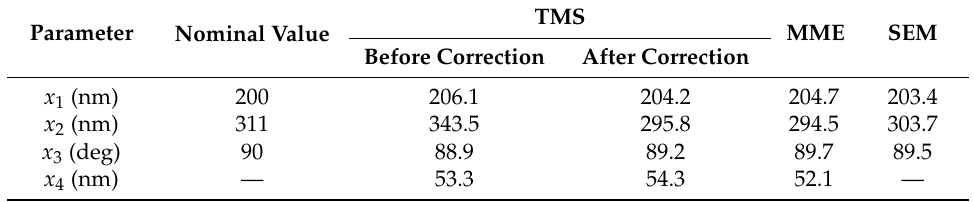
Table 1. Comparison of the fitting parameters of the photoresist grating extracted from TMS, MME, and SEM